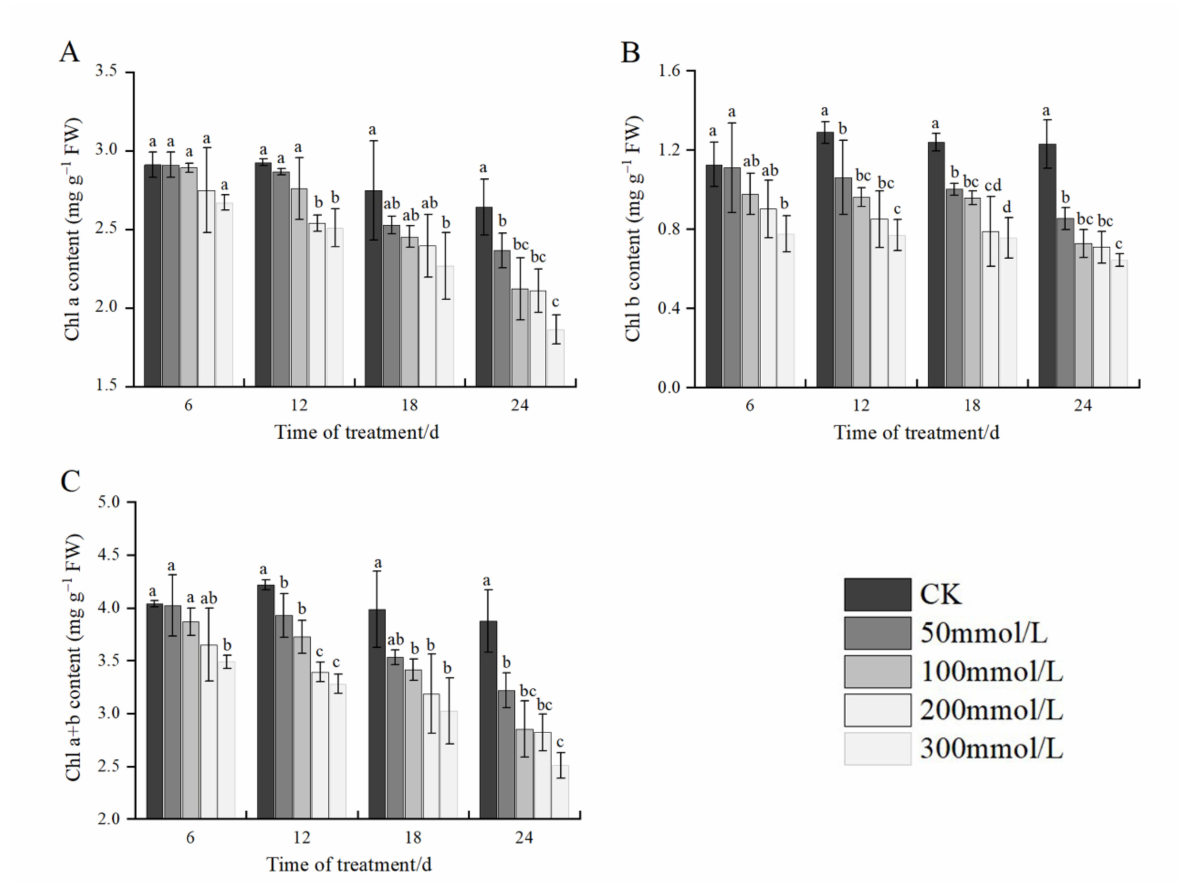
Figure 1. The effect of salt stress on chlorophyll content of J. microcarpa L. seedlings. ( A ) Chlorophyll leaves. Error bars indicate the SD of treatment means. Different letters on the bars indicate significant differences among the treatments ( p <